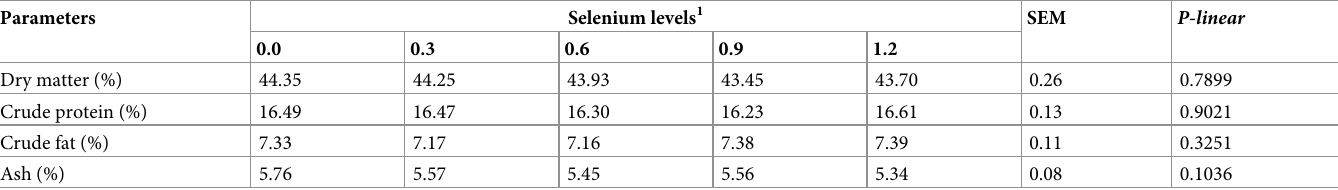
Table 5. Meat chemical composition of juvenile silver carp fed on different levels of selenium methionine. Parameters